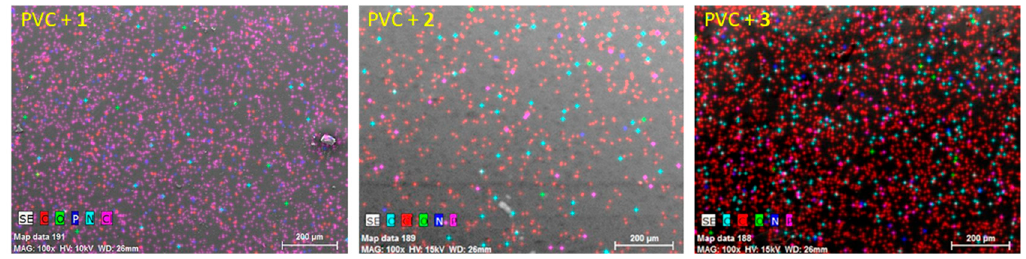
Figure 3. EDX chemical mapping patterns of PVC films.